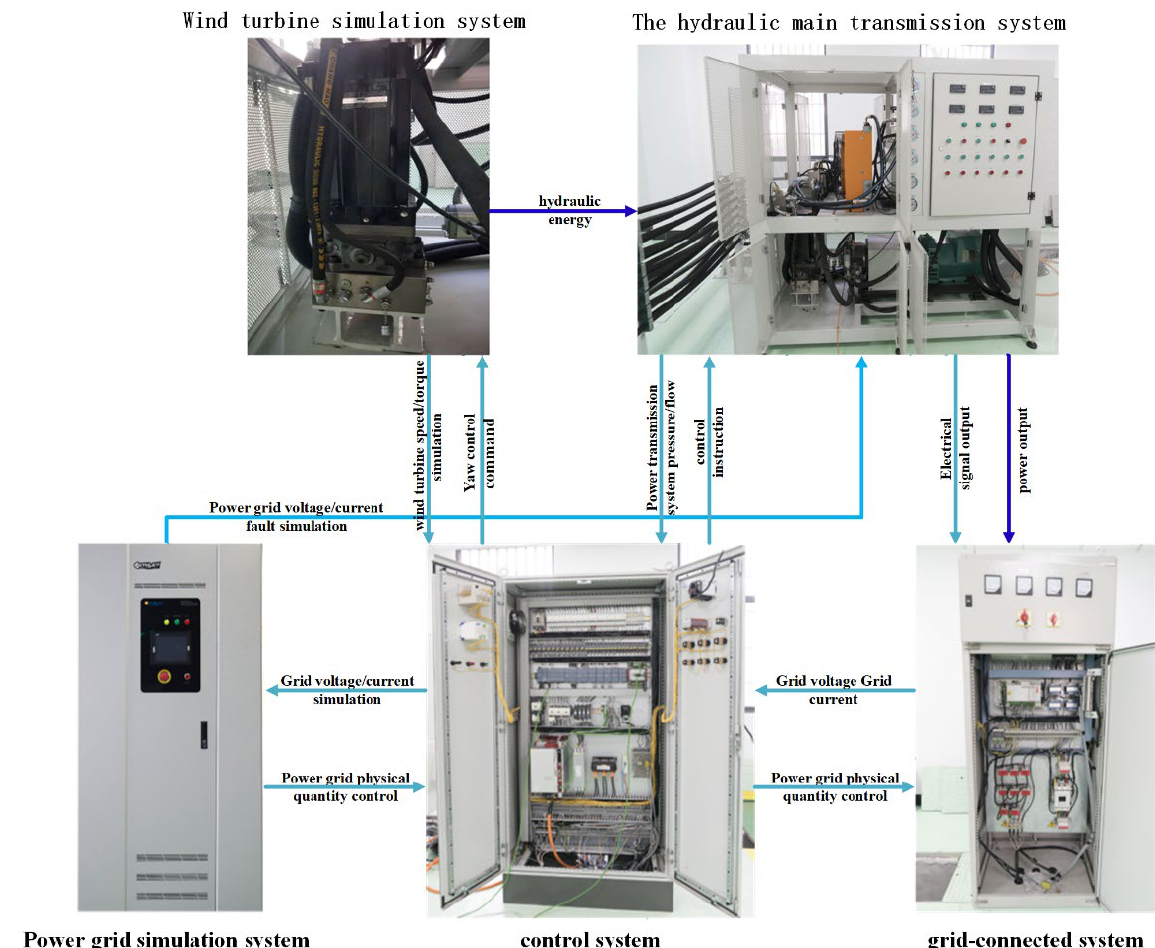
Figure 21. Hydraulic transmission system equipment drawing.